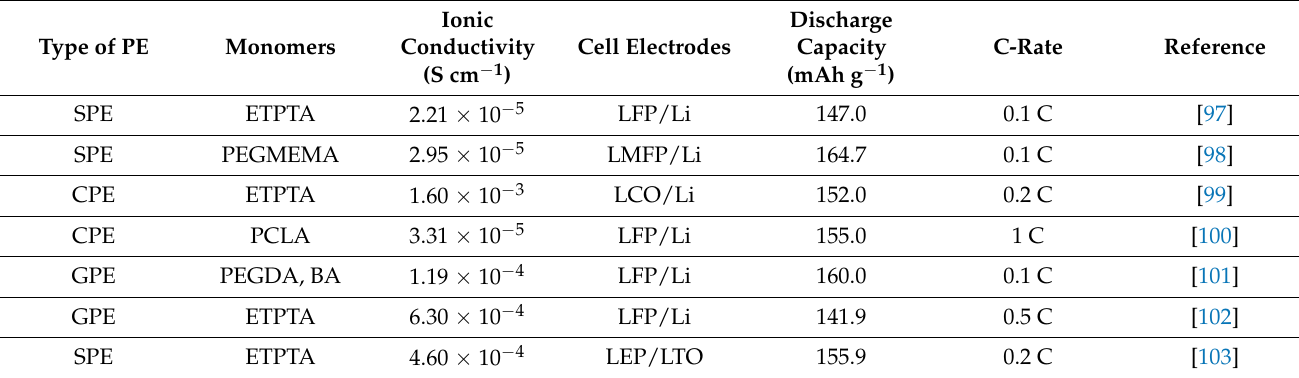
Table 6. Polymer electrolytes using UV